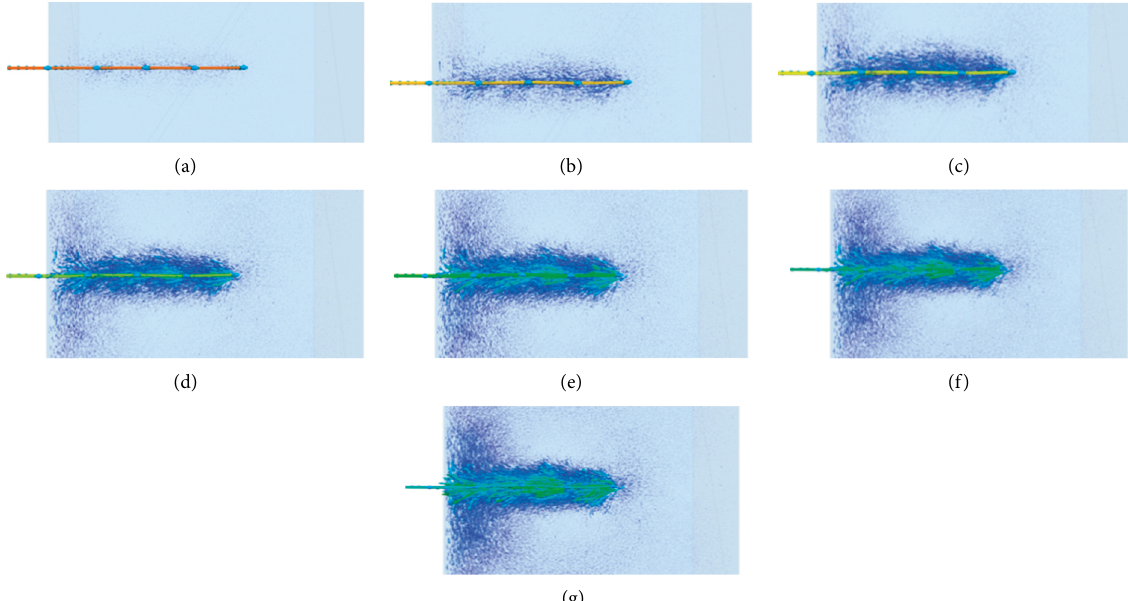
Figure 10: Evolution of the displacement vectors of soil particles under a load of 25 kPa. (a) L � 2mm, (b) L � 4mm, (c) L � 6mm,